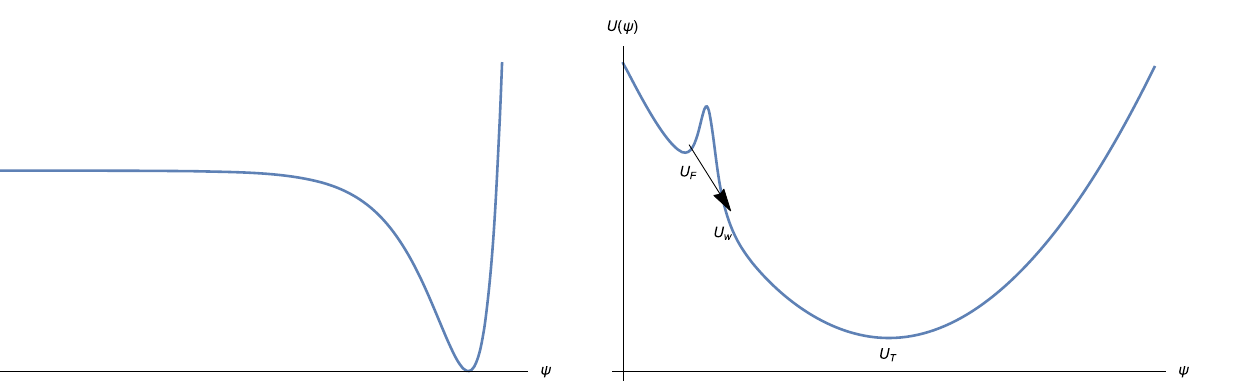
Fig. 1 Schematic representation of a potential for a standard Emergent Universe scenario